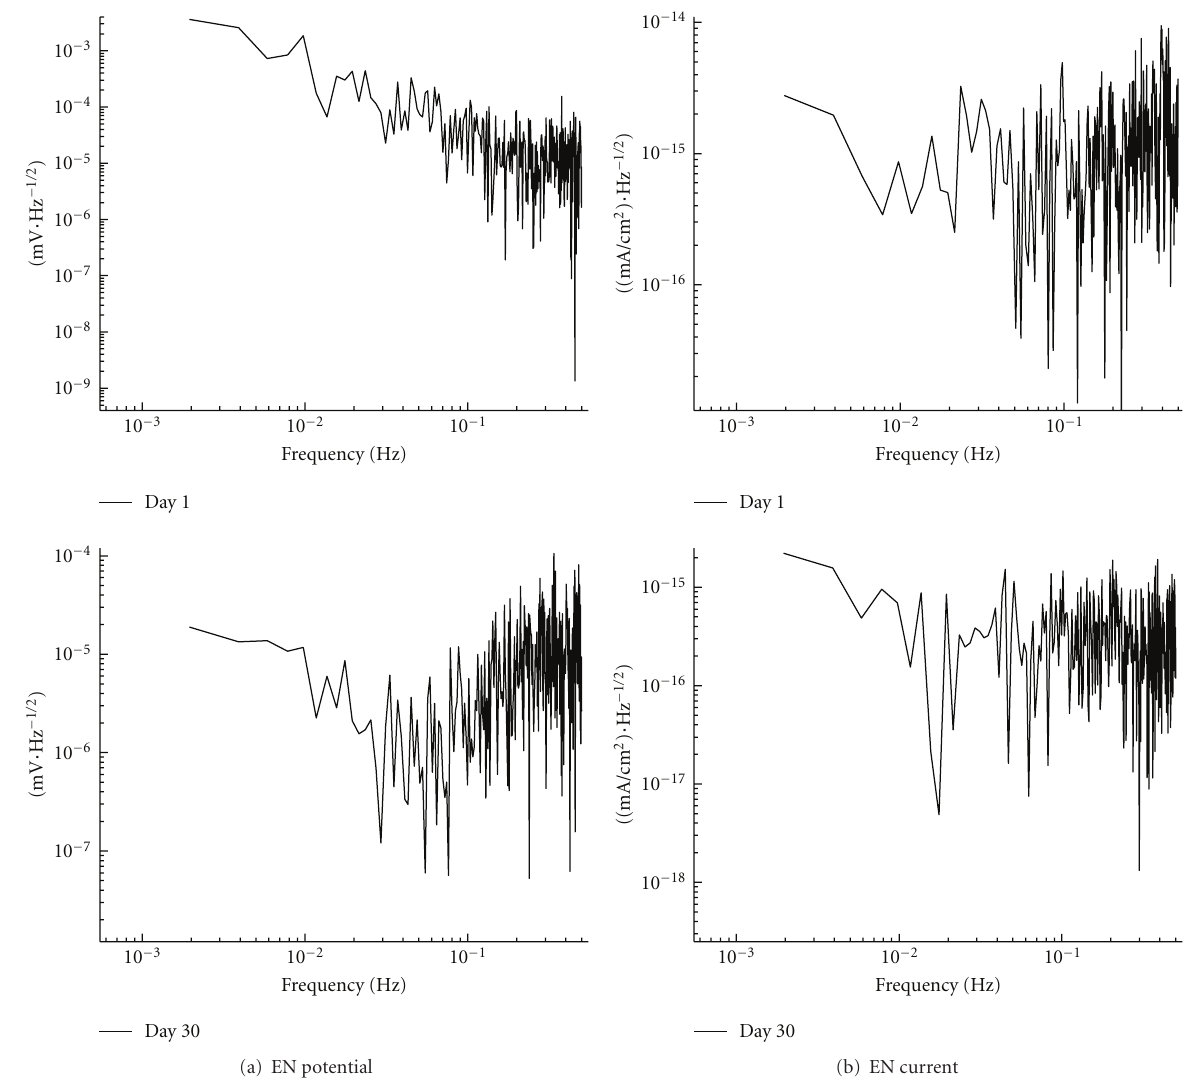
Figure 4: EN spectral density plots for 1 and 30 days of